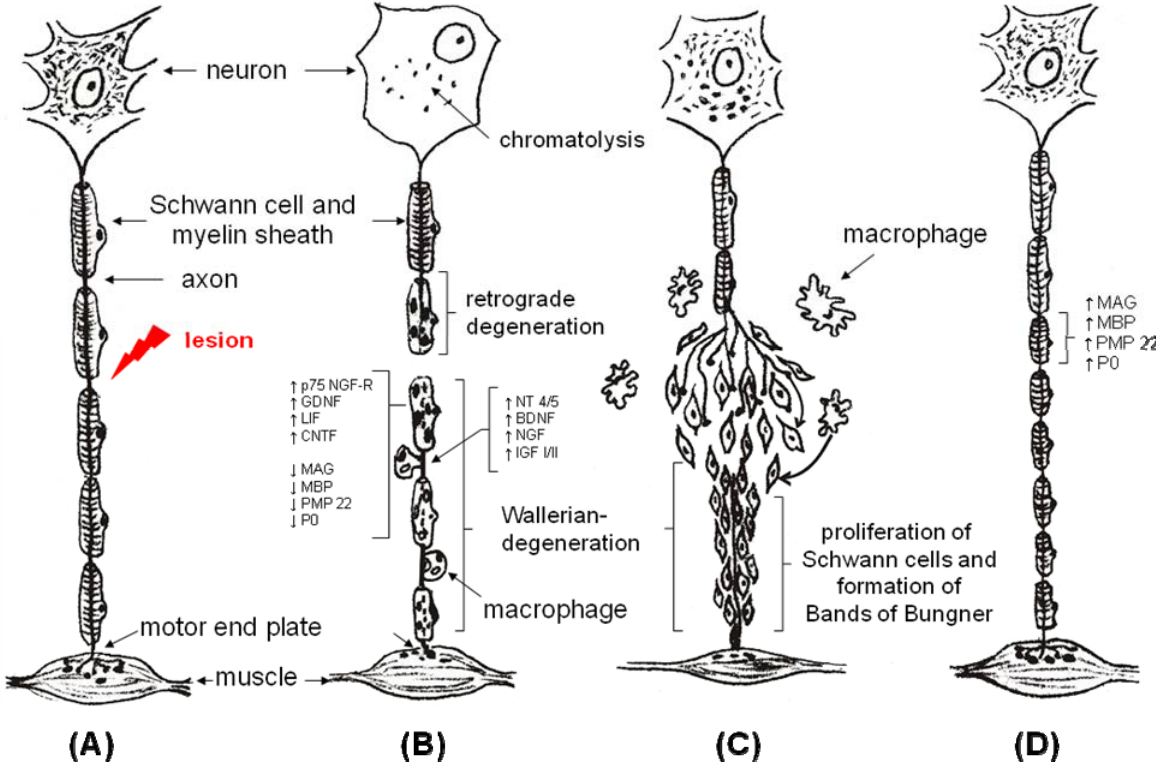
Figure 1. Wallerian degeneration and axonal